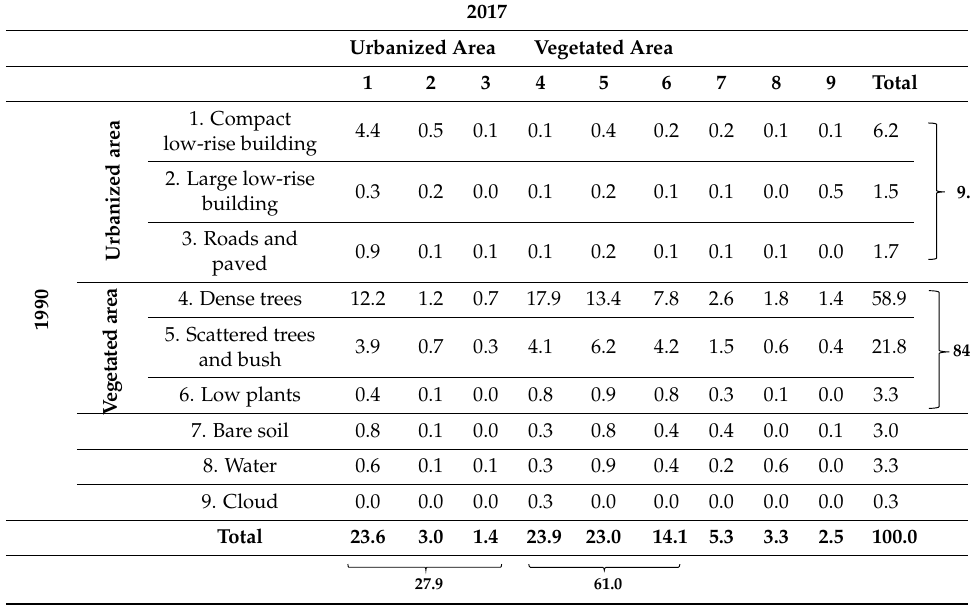
Table 5. The transition matrix of LCZ change between 1990 and 2017.